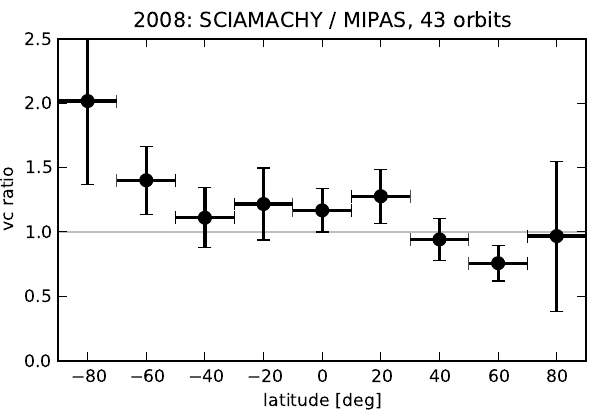
Fig. 11. Ratio of SCIAMACHY to MIPAS NO vertical columns (70–140km), averaged in 20 ◦ latitude bins from 43 coincident or- bits in 2008. The horizontal bars indicate the bins and the vertical bars the 3 σ confidence